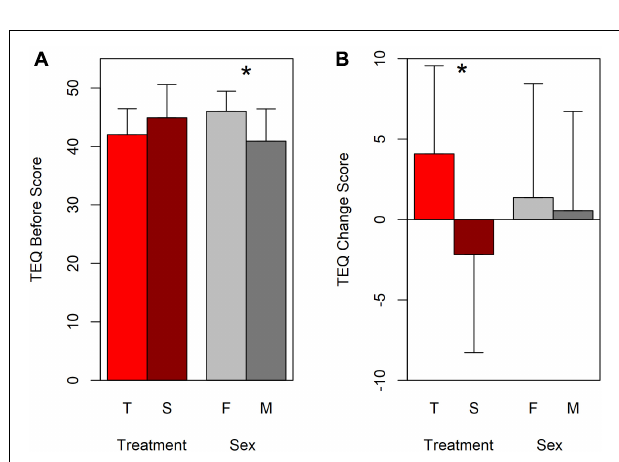
FIGURE 2 | Mean scores and standard deviations for TEQ Before (A) and Change (B) . Red shaded bars: mean scores for Treatment group, T, Turn-taking; S, Synchrony. Gray shaded bars: mean scores for Sex, F, Female; M, Male. Error bars = standard deviation. Positive Change scores represent improved performance (After > Before). * Between bars: p < 0.025 in ANOVA.